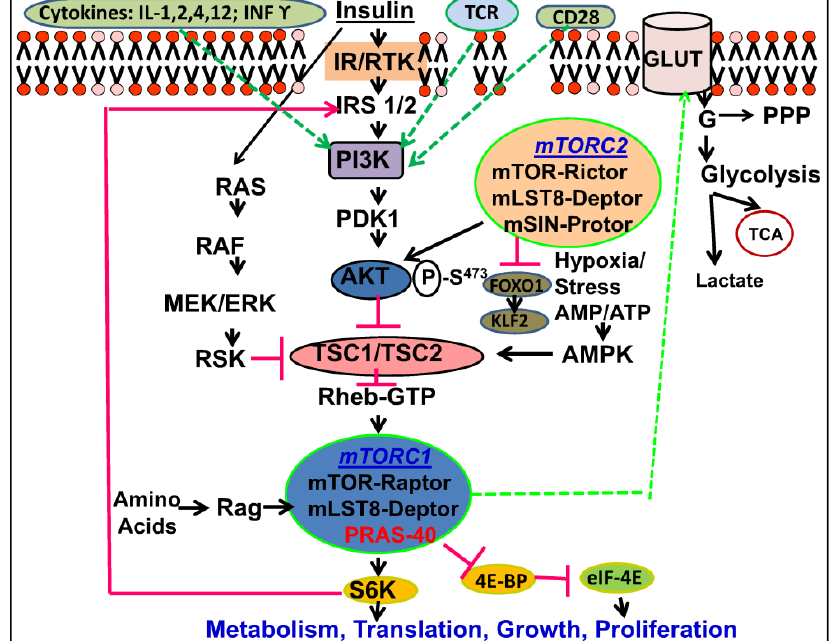
Figure 1. Network of the mechanistic Target of Rapamycin (mTOR) signaling